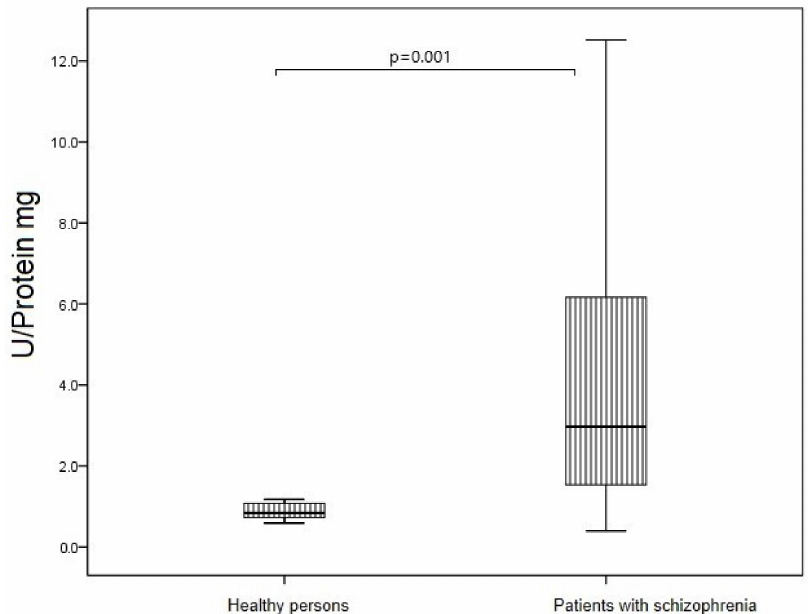
Figure 8. SOD activity of blood erythrocytes in patients with acute schizophrenia and healthy persons. Note: U—corresponds to the amount of enzyme that catalyzes the conversion of 1 µ moof substrate in 1 min at +25 ◦ C.